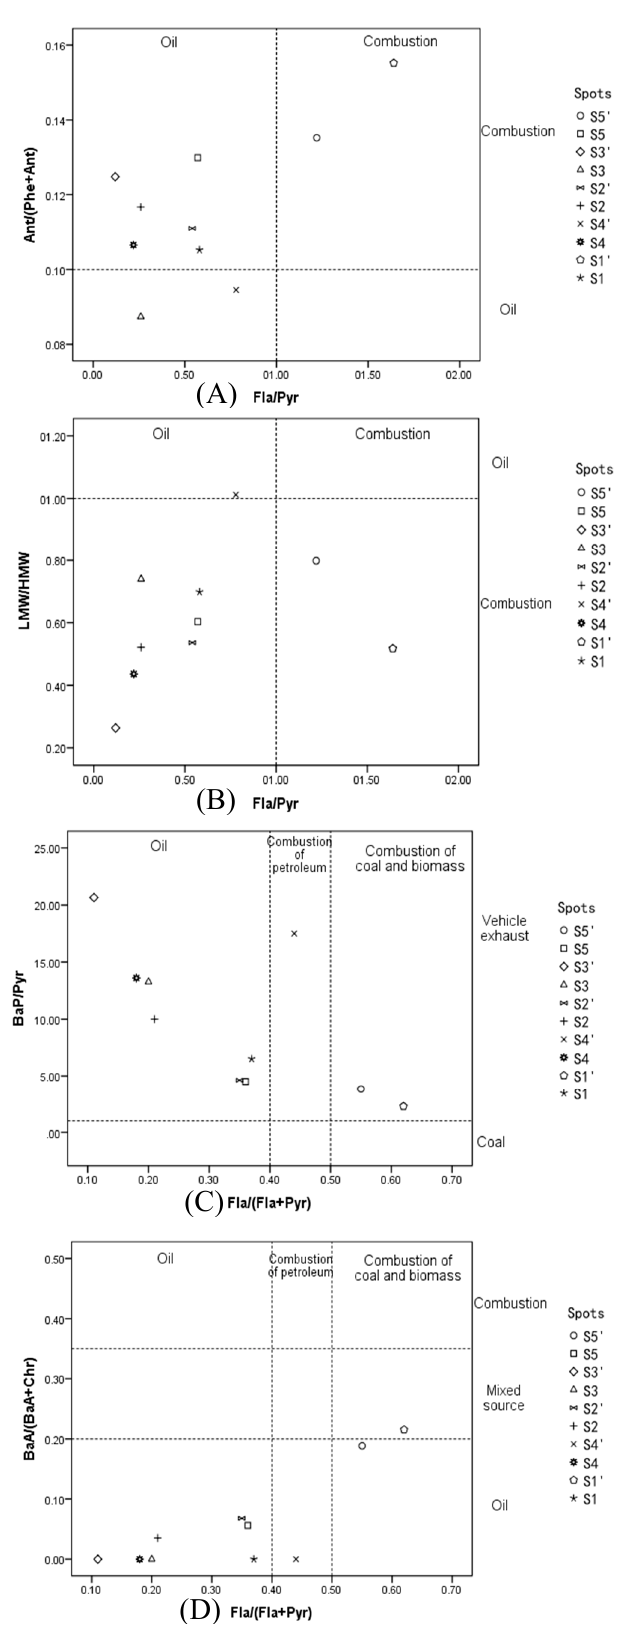
Figure 4. The results of PAHs source ratio analysis. ( A ) Ratios of Fla / (Pyr) vs. Ant / (Ant + Phe), ( B ) Fla / (Pyr) vs. LMW / HMW ( C ) Fla / (Fla + Pyr) vs. BaP / Pyr, ( D ) Fla / (Fla + Pyr) vs. BaA / (BaA + Chr)